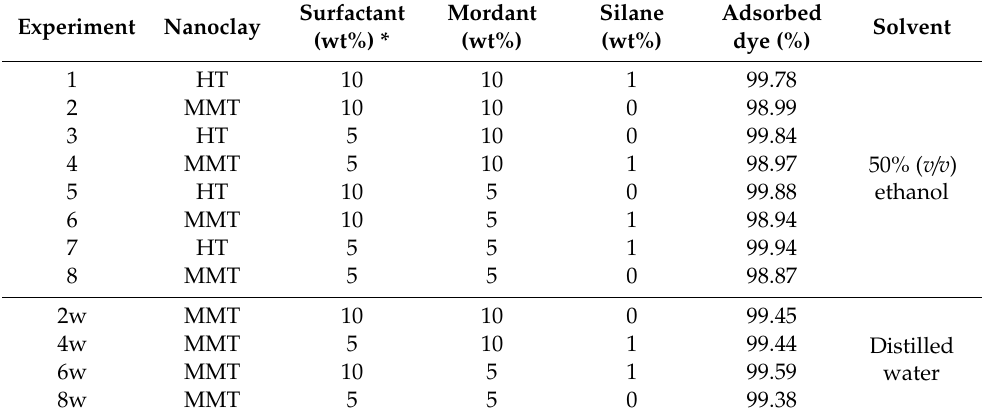
Table 2. 2 4 − 1 fractional experimental design matrix, additional experiments performed with water as solvent and lemon dye adsorbed over the initially added dye